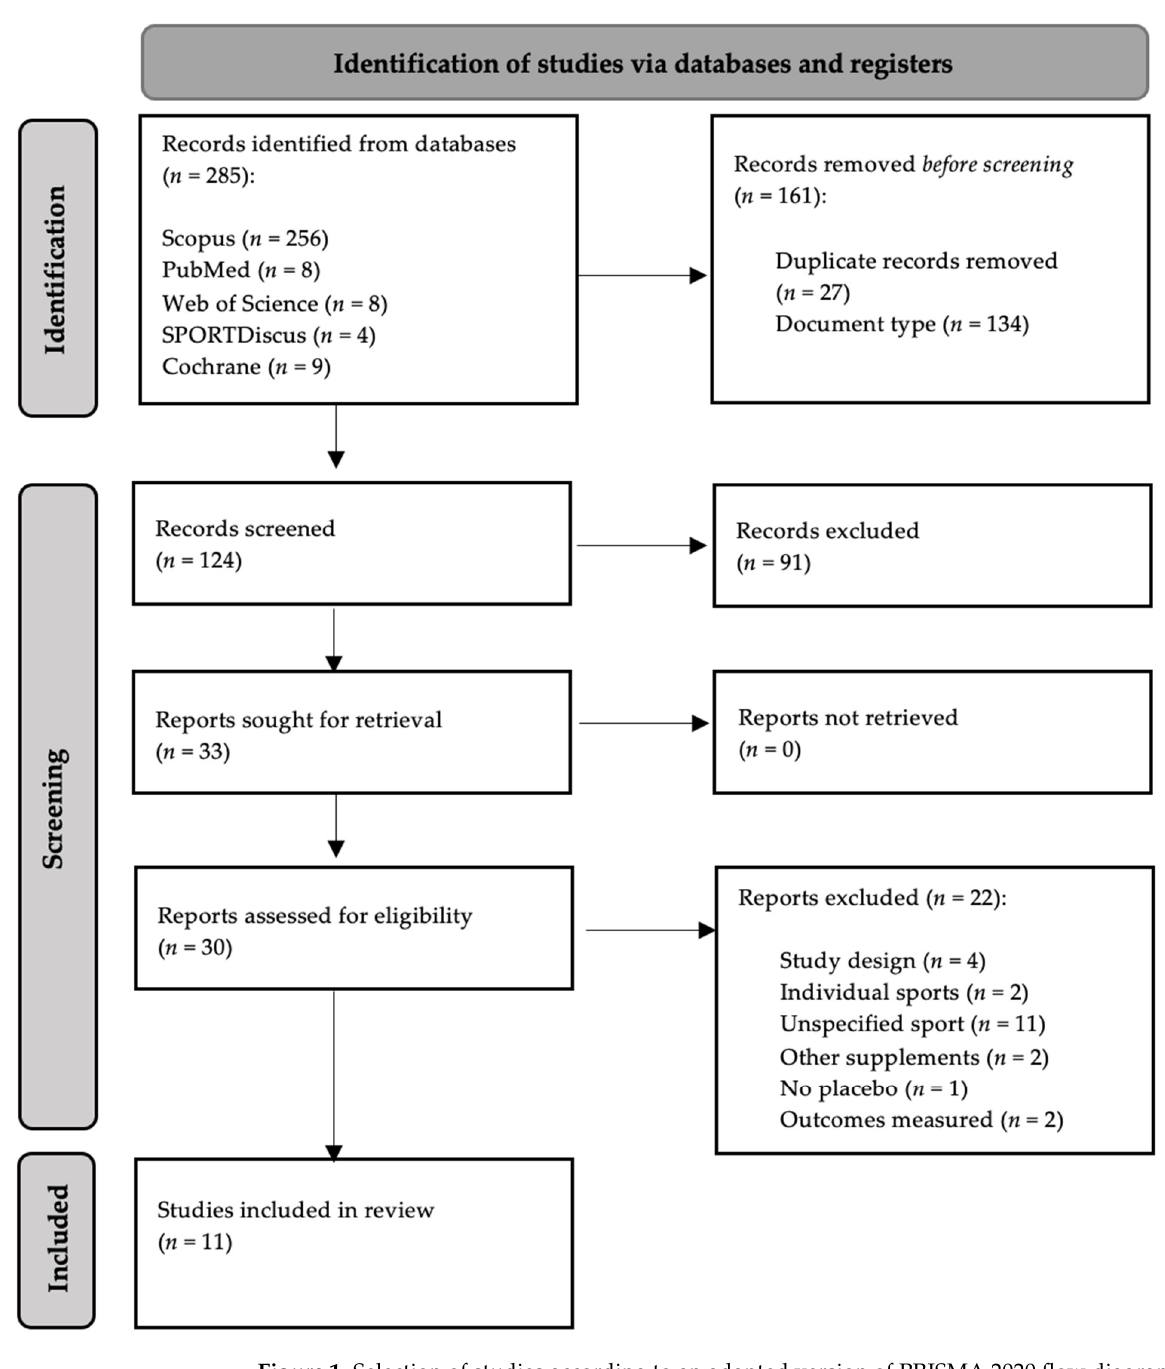
Figure 1. Selection of studies according to an adapted version of PRISMA 2020 flow diagram [24].